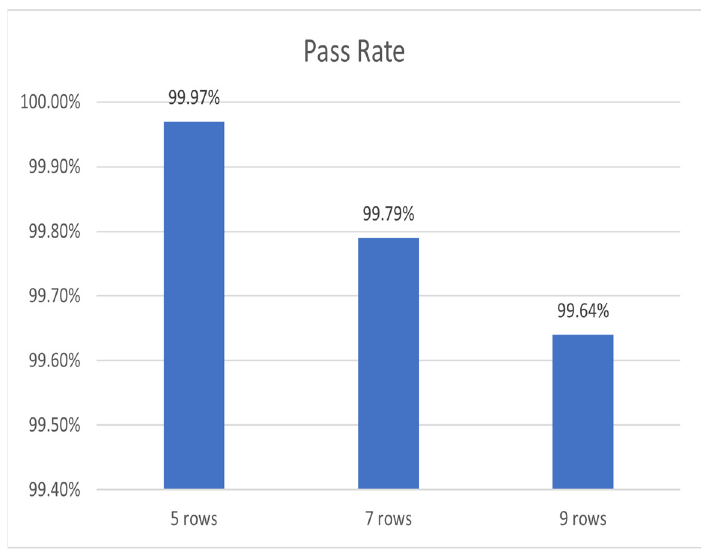
Figure 10. Relationship between Seeding Quality and Number of Seeding Rows.